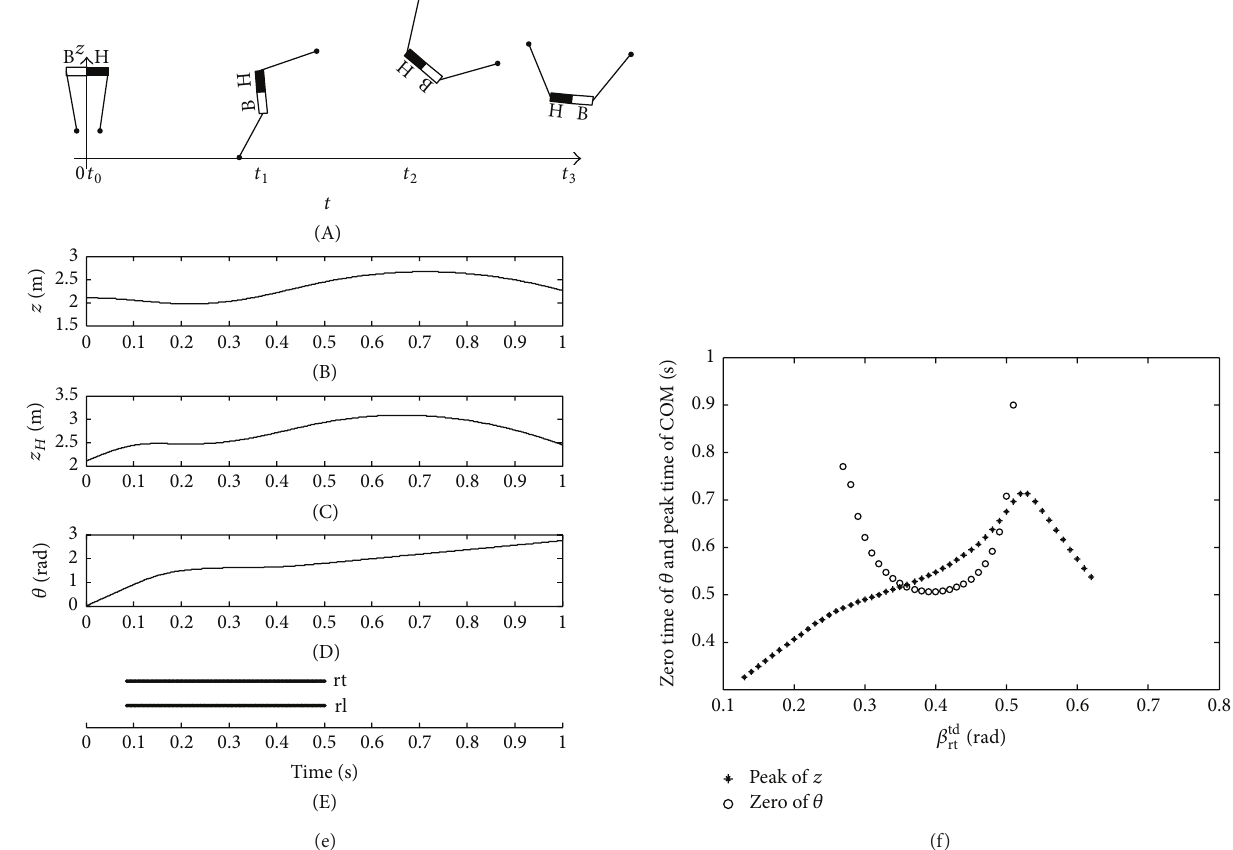
Figure 19: Imbalance and balance postures of giraffe. (a) The imbalance posture when 𝛽 td rt = 0 . 14 rad; (b) the balance posture when 𝛽 td rt = 0 . 34 rad; (c) the imbalance posture when 𝛽 td rt = 0 . 42 rad; (d) the balance posture when 𝛽 td rt = 0 . 50 rad; (e) the imbalance posture when 𝛽 td = 0 . 53 rad; (f) the zero time of pitching angle and the peak time of COM. rt